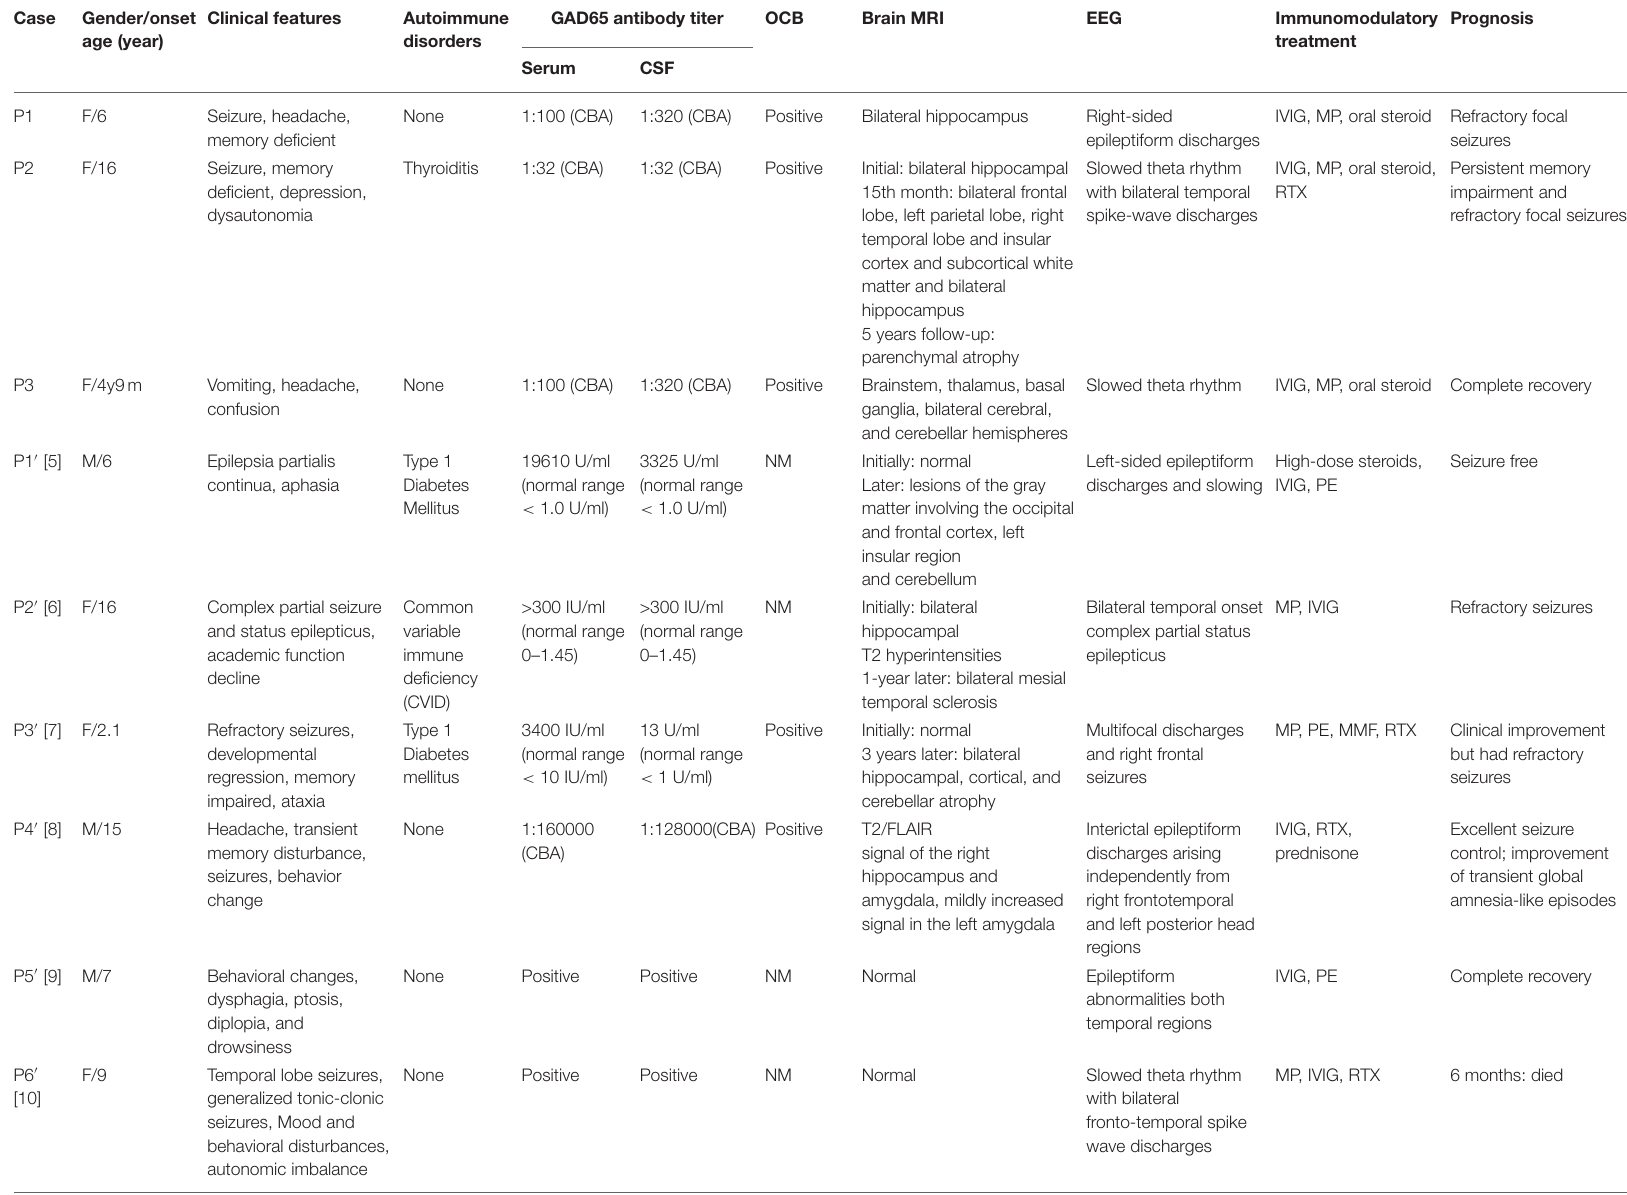
TABLE 1 | Pediatric cases of anti-GAD65 antibody-associated encephalitis in our study and previous studies.